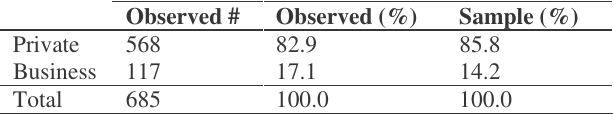
Table 6. Car possession and ‘presentation of badly visible objects on